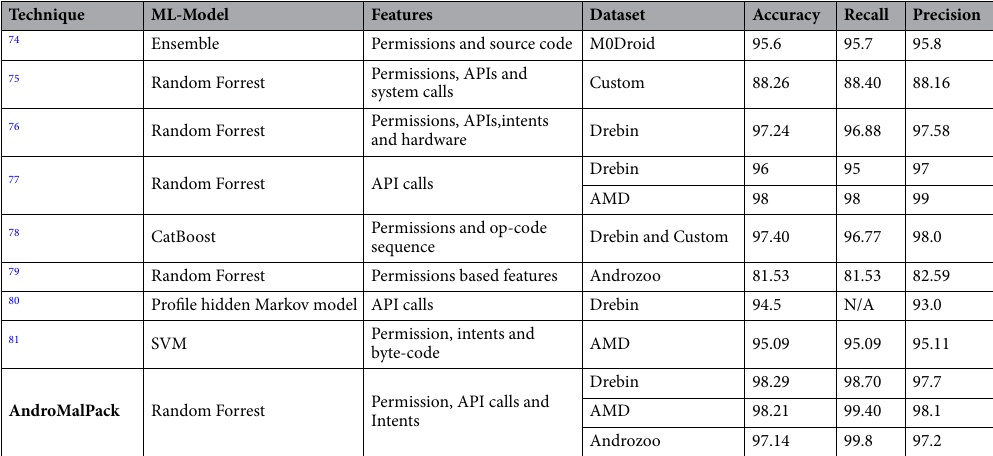
Table 11. Comparison of AndroMalPack with related